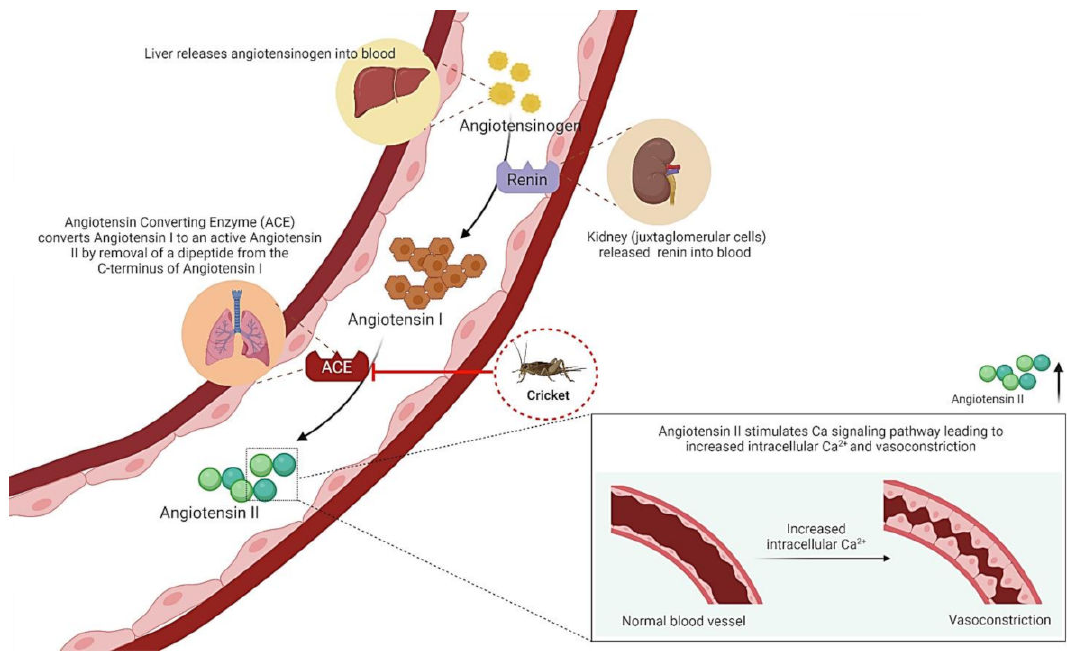
Figure 6. Blood pressure regulation and how crickets extract reduces blood pressure. The angiotensin- converting enzyme (ACE) will convert angiotensin I to angiotensin II, which leads to increased intracellular Ca 2+, vasoconstriction and hypertension. Cricket extract inhibits ACE and decrease angiotensin